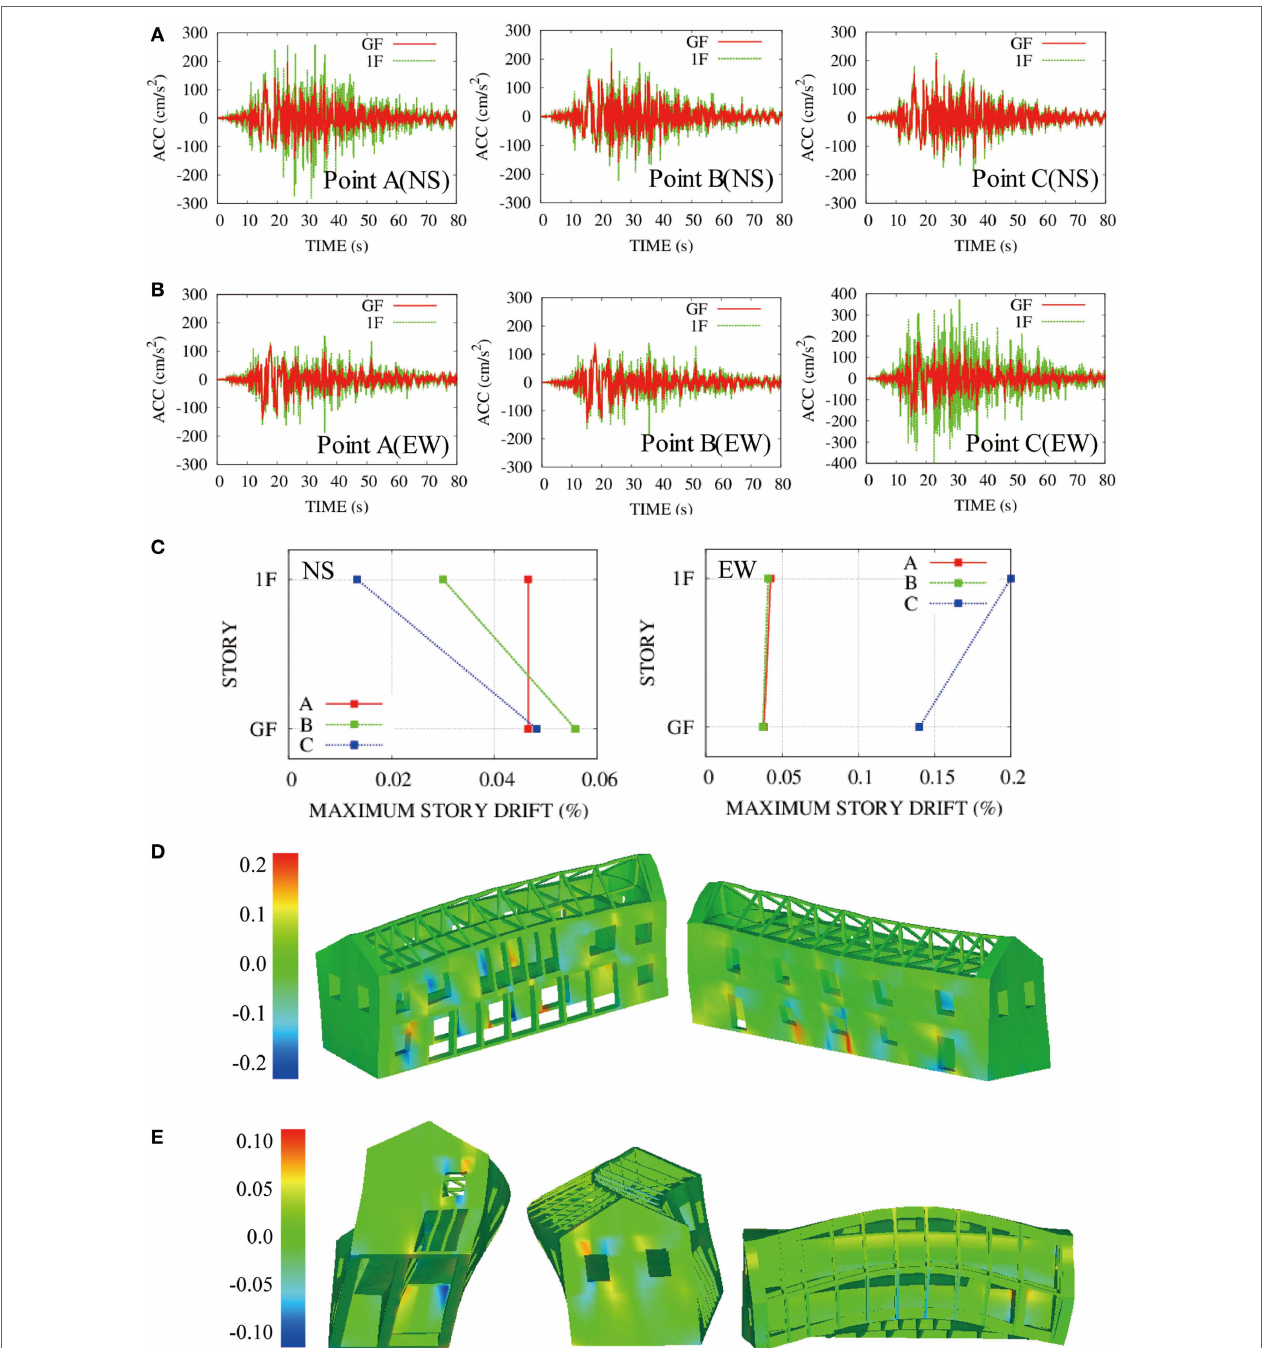
FIGURE 11 | Results of the dynamic analysis. (A) Acecleration response in NS direction. (B) Acecleration response in EW direction. (C) Maximum story drift. (D) Shear strain distribution in the xz -plane at 26s. (E) Shear strain distribution in the yz -plane at 29s.